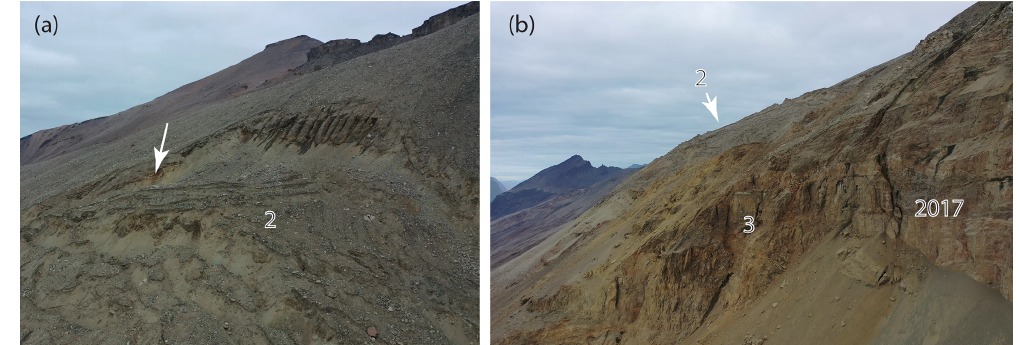
Figure 7. Drone field photos from the Karrat Landslide Complex in the summer of 2019. (a) Drone photo of the back scarp of area 2. The arrow points to where bedrock is exposed, indicating that the unstable rock slope is not a superficial feature. (b) Drone photo of the back scarp of the Karrat 2017 rock avalanche looking towards the NW. The mottled interior of area 3 is apparent along with the bulging nature of area 2 in the background. See Fig. 1b for